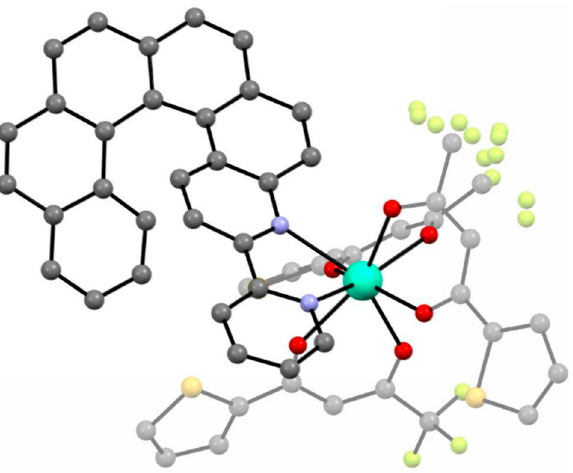
Figure 3. The crystal structure of [Dy(tta) 3 (L1)] ( 2 ). Dy—teal, O—red, C—gray, N—blue, F—bright yellow, S—yellow.